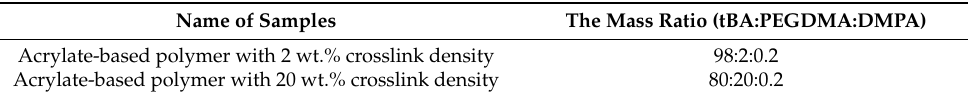
Table 1. The polymer synthesized in this work. Name of